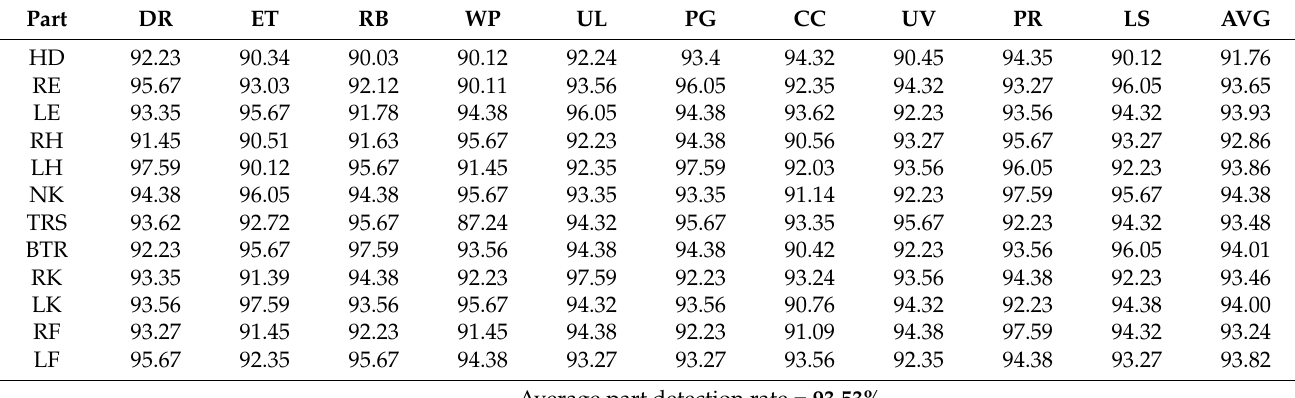
Table 4. Body part detection rate achieved over MSR Daily Activity 3D